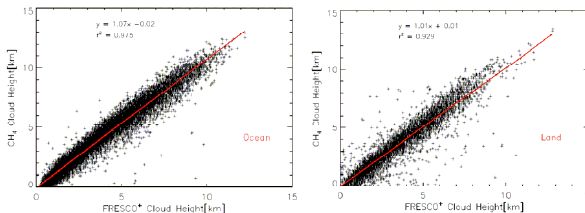
Fig. 5. Comparison of effective cloud height retrieved from the CH 4 Fig. 5 Comparison of effective cloud height retrieved from the CH 4 absorption around 2330 nm with the effective cloud height retrieved from the FRESCO+ algorithm absorption around 2330nm with the effective cloud height retrieved around 760 nm over ocean (left) and land (right) for January and February 2005. from the FRESCO + algorithm around 760nm over ocean (left) and land (right) for January and February